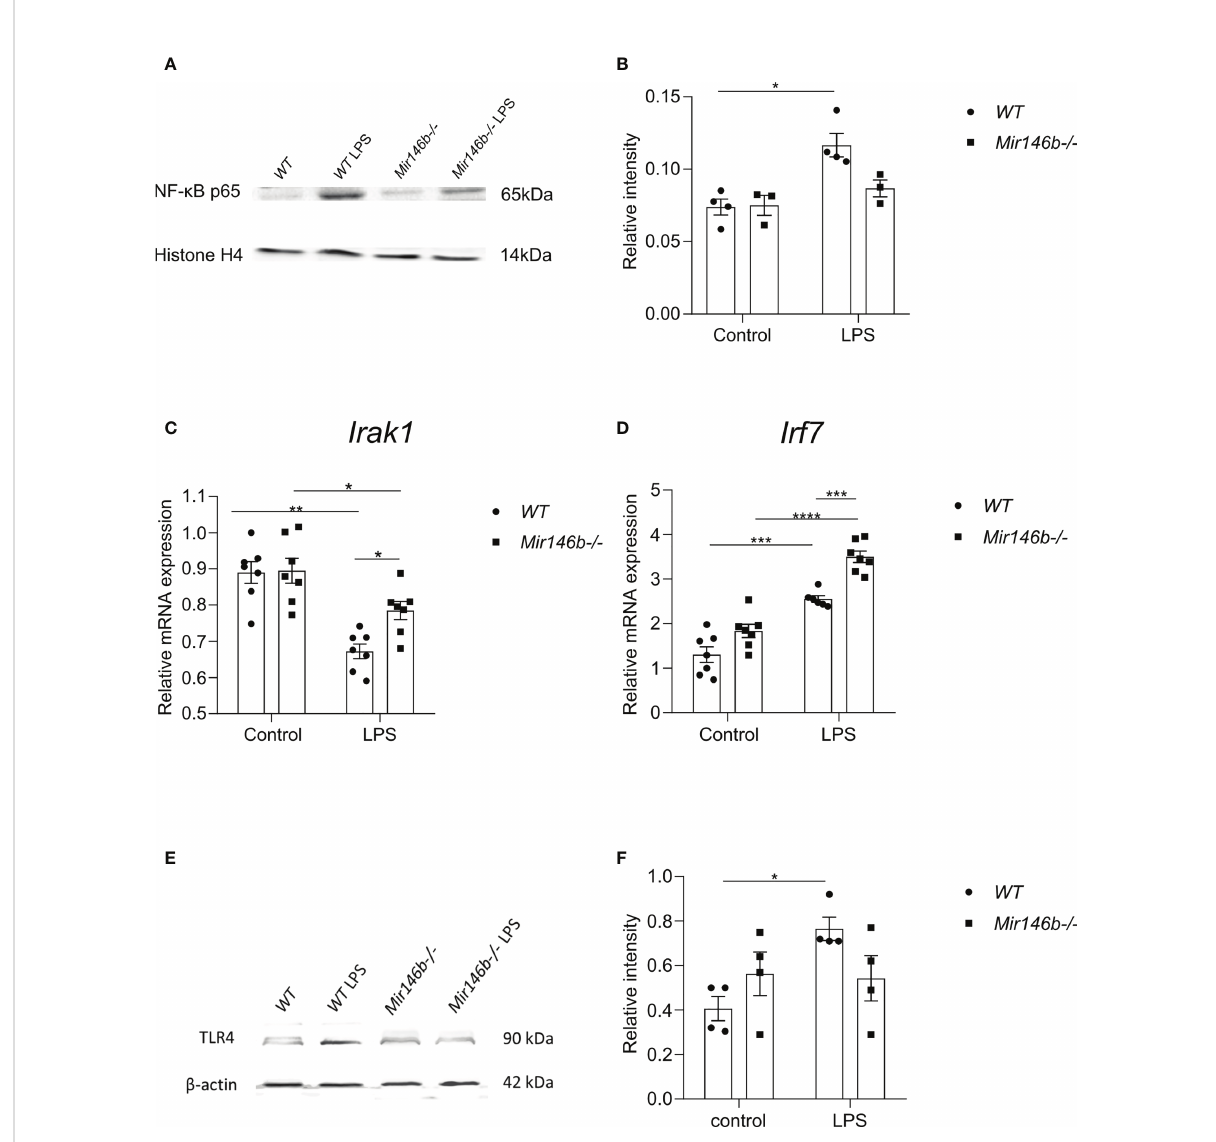
FIGURE 10 Effects of LPS on the activation of NF- k B, Irak1 mRNA, miR-146a-transcriptional regulator Irf7 and TLR4 protein expression levels in Mir146b-/- mice. (A) Representative immunoblot of hippocampal lysates probed for NF- k B p65 and histone H4 in the nuclear fractions of saline and LPS treated WT and Mir146b-/- mice. (B) Densitometry quanti fi cation of NF- k B p65 in the nuclear fractions was performed (C) Relative expression Irak1 mRNA levels in qPCR (D) Relative expression of Irf7 (E) Representative immunoblot probed for TLR4 and b actin and (F) Densitometry quanti fi cation of TLR4 in the hippocampal tissue isolated from saline and LPS treated WT and Mir146b-/- mice. Number of animals = 3-4 (Western blot) and 6-7 (qPCR). Data represented as mean ± SEM; * p < 0.05, ** p < 0.01, *** p < 0.001, **** p < 0.0001 (Two-way ANOVA with Tukey ’ s multiple comparison